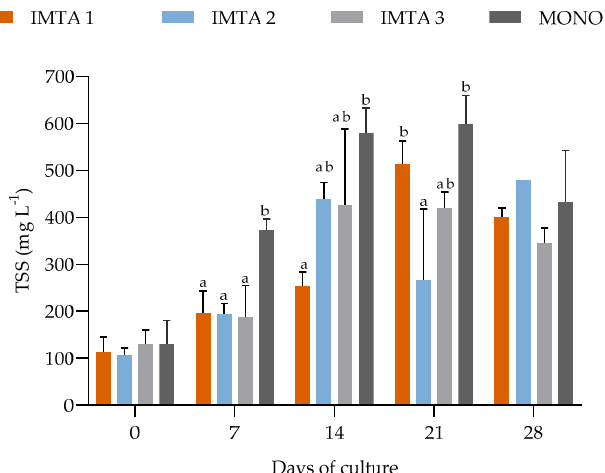
Figure 4. Variations in the total suspended solids (TSS) in the IMTA 1 (with 1 g Ulva L − 1 ), IMTA 2 (2 g Ulva L − 1 ), IMTA 3 (3 g Ulva L − 1 ), and MONO C (with no Ulva) treatment groups during the 35 days of cultivation. a; b= Different lowercase letters on the same day represent a significant differ- ence ( p ≤ 0.05) between the treatments after ANOVA followed by Tukey’s post-hoc test. There was no significant difference ( p ≤ 0.05) in the shrimp performance parameters between the treatment groups (Table 7). Table 7. The performance of shrimp L. vannamei (mean ± standard deviation) in treatments of MONO C (with no Ulva) in the IMTA 1 (with 1 g Ulva L − 1 ), IMTA 2 (2 g Ulva L − 1 ), and IMTA 3 (3 g Ulva L − 1 ) treatment groups during the 35 days of culture.